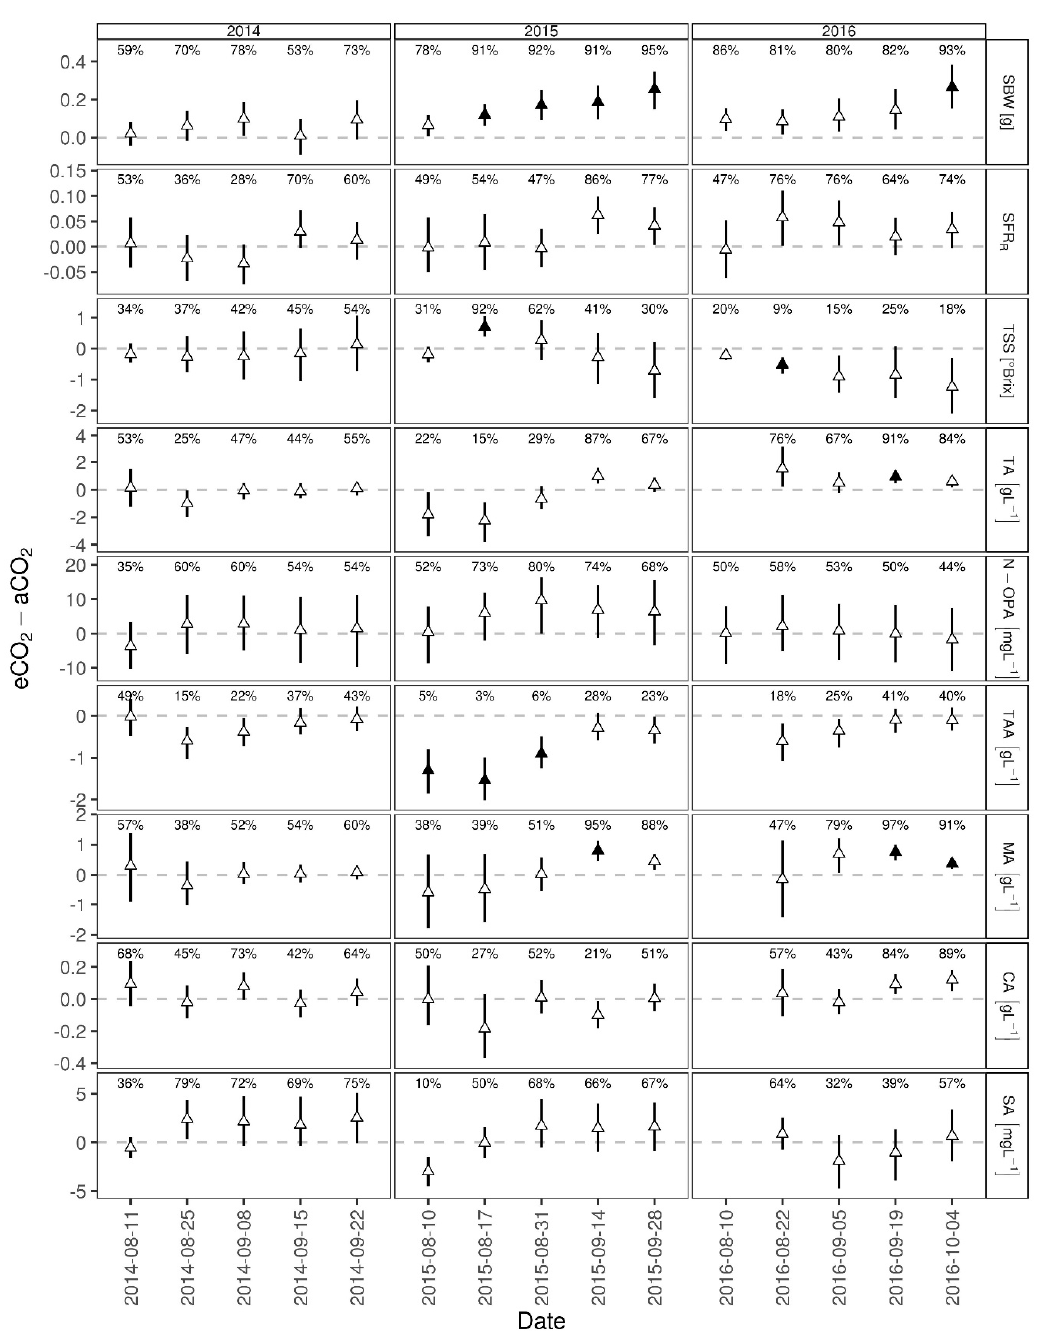
Figure 8. Posterior predicted difference (median and 50% HDI) between eCO 2 and aCO 2 for each measurement date from Bayesian generalized linear mixed effects models on berry quality parameters of Riesling. Percentages represent the probability of eCO 2 − aCO 2 > 0. Filled symbols indicate “significant differences”, if the probability is >90% (positive difference) or <10% (negative difference).